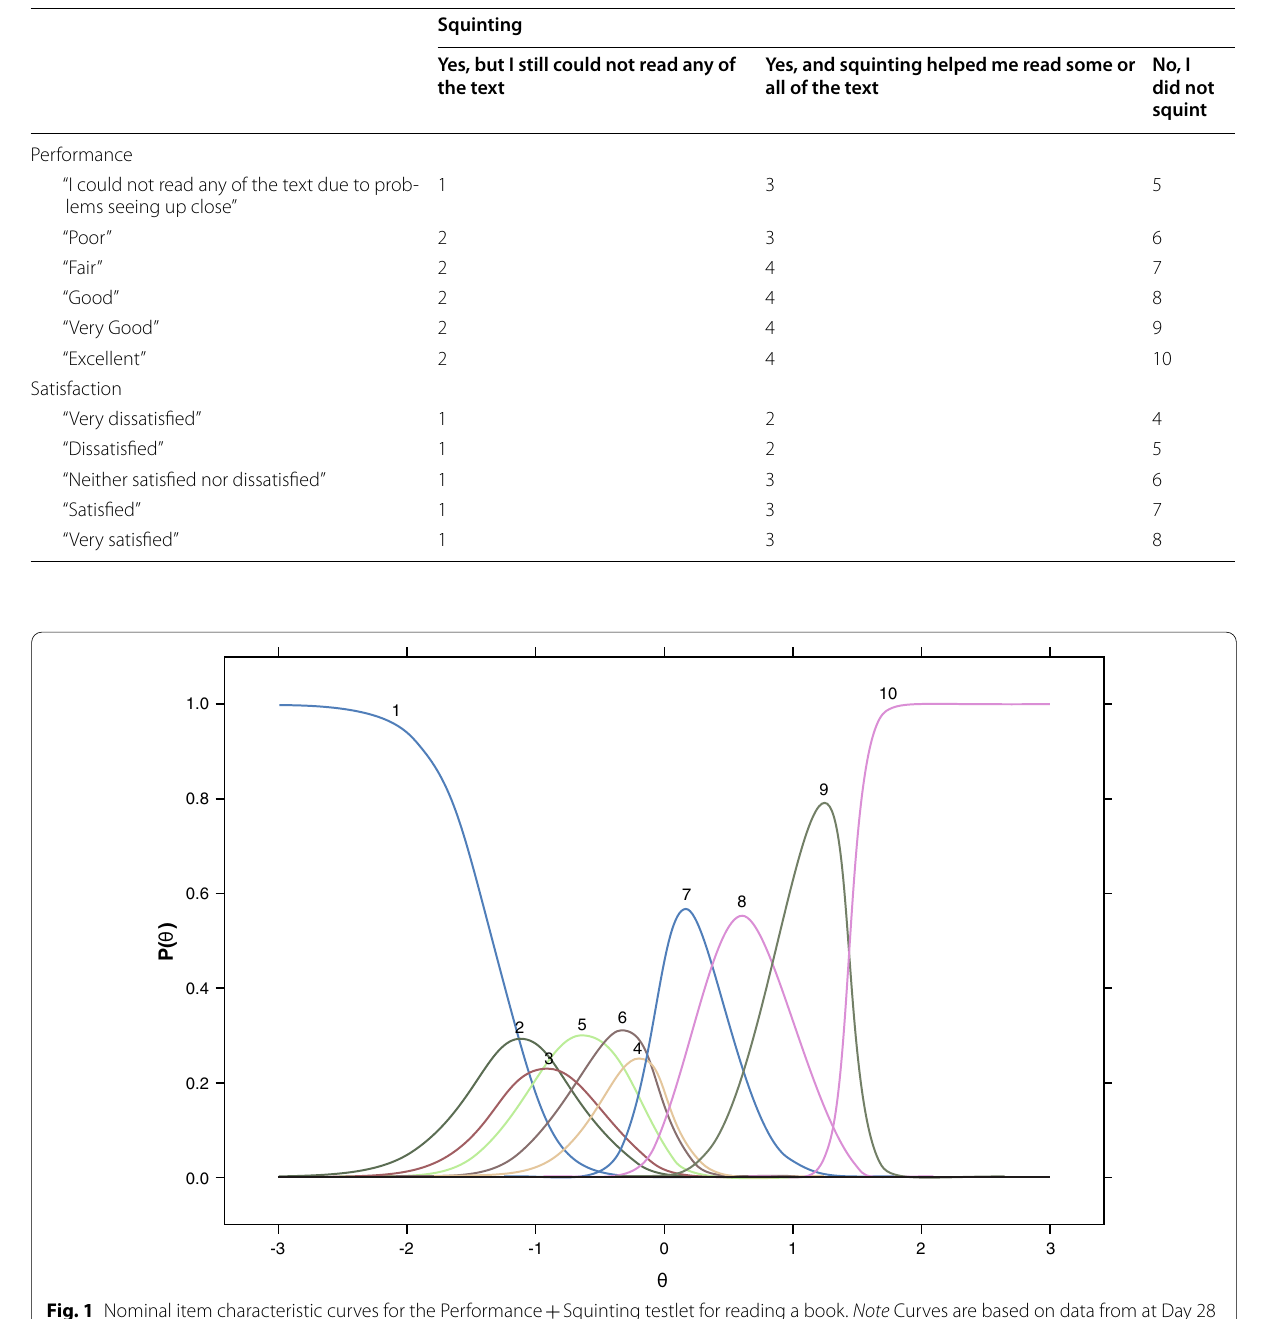
Table 4 Testlets variables for Performance